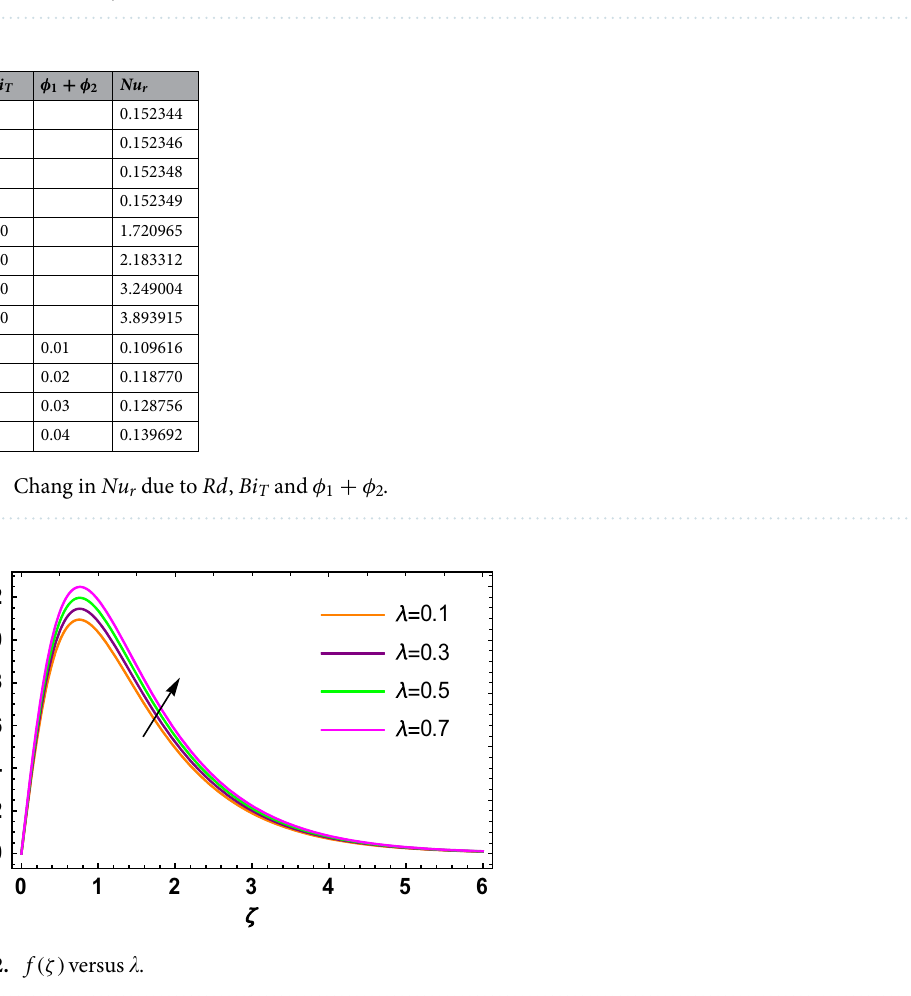
Table 3. Chang in C fr due to M , (cid:31) and φ 1 + φ 2 .